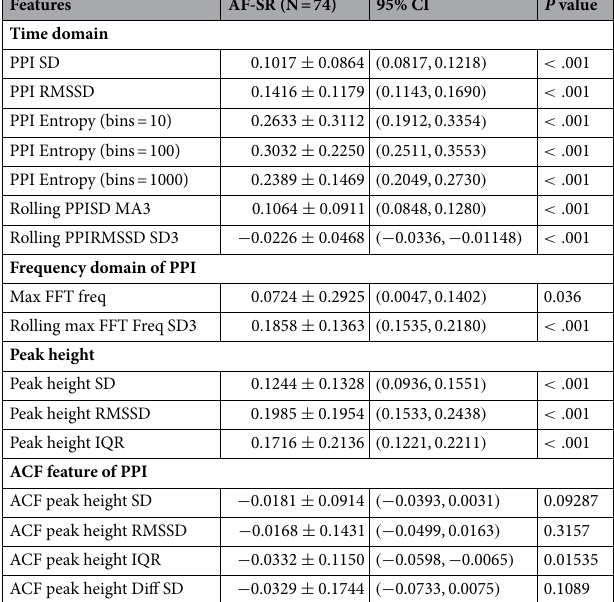
Table 3. Univariate analysis of the within-subject mean difference between the average of PPG features of 25-beat PPI segments for AF and SR.